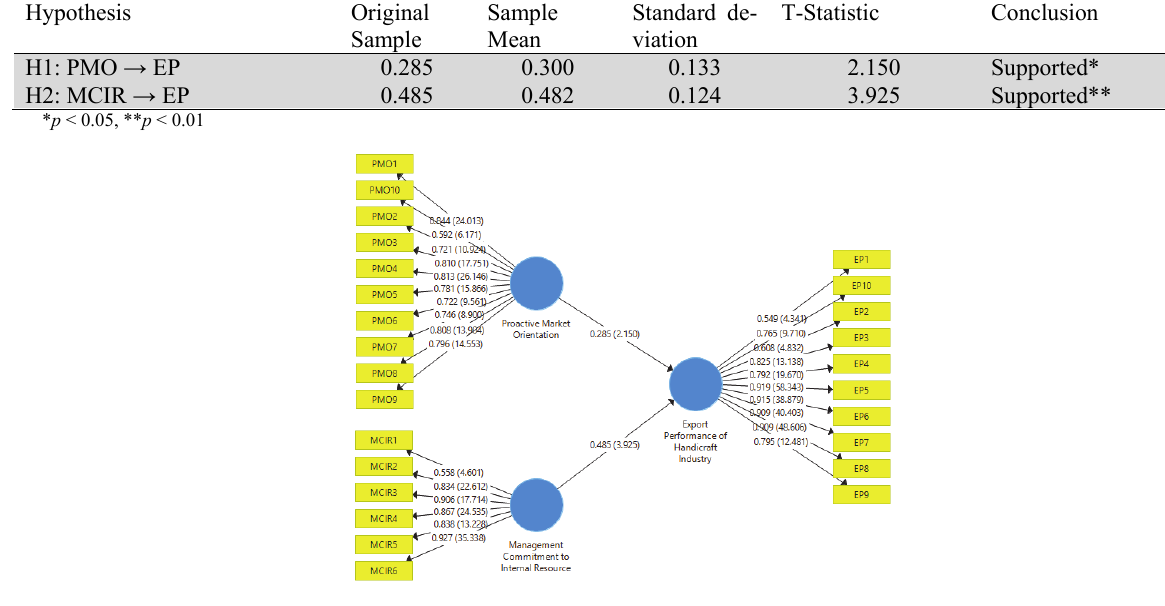
Fig. 2. Structural